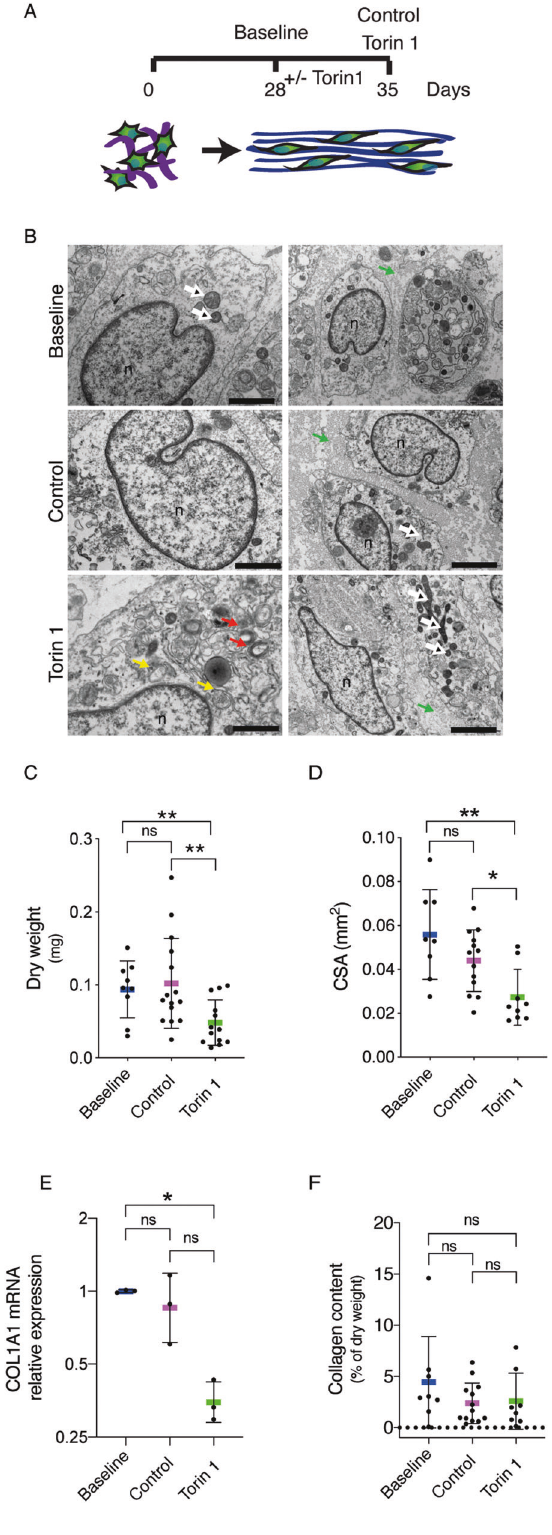
fi broblasts and osteosarcomas cells [18]. As a matter of fact, we found out that any alteration of autophagy fl ux — ectopically induced in tendon cells by both inhibiting (with BafA1 and siAtg7) and enhancing autophagy fl ux (with Torin1) — affected the correct synthesis of PC1, tendon homeostasis, and properties. In